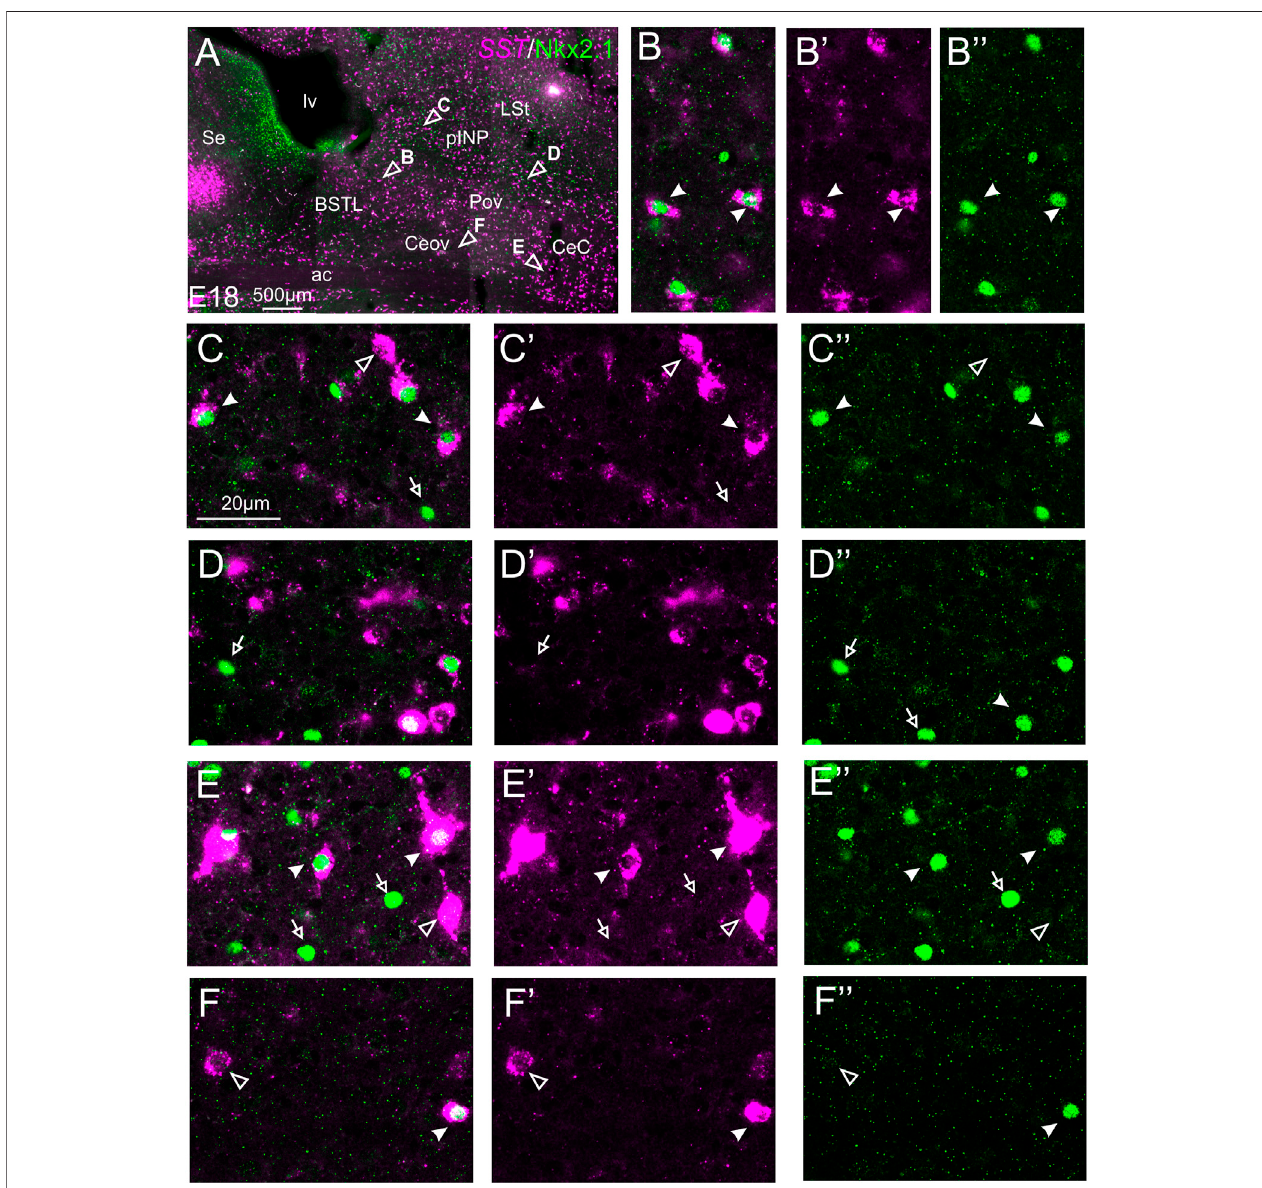
FIGURE 9 | Double fl uorescence labeling of somatostatin ( SST ) and Nkx2.1 in the chicken central extended amygdala at E18. (A) General view (×10 objective) of the subpallium in a frontal section at the level of the anterior commissure, processed for indirect fl uorescent in situ hybridization for SST (magenta) and immuno fl uorescence for Nkx2.1 (green). Details (×40 objective, only one single z level of the confocal stack) of the areas pointed with arrowheads in (A) are shown in (B – B 99 ) (for lateral BSTL), (C – C 99 ) (for medial pINP), (D – D 99 ) (for lateral pINP), (E – E 99 ) (for CeC), and (F – F 99 ) (for Ceov) (merged plus separate magenta and green channels are shown). In these details, cells coexpressing SST and Nkx2.1 are pointed with a fi lled arrowhead, cells single labeled for SST are pointed with an empty arrowhead, and cells single labeled for Nkx2.1 are pointed with an empty arrowhead (only a few examples are pointed). See text for more details. For abbreviations